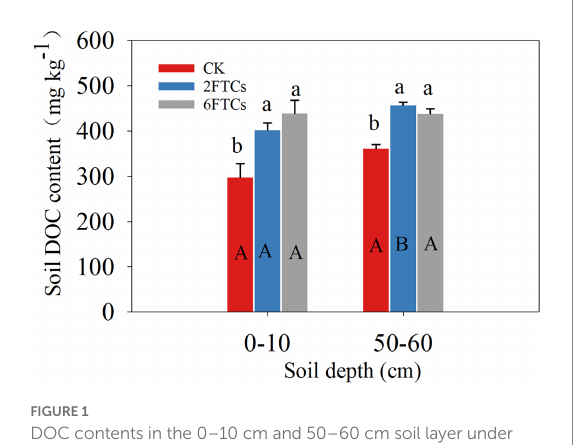
FIGURE 1 DOC contents in the 0–10 cm and 50–60 cm soil layer under different freeze–thaw cycles. CK was cultured at 5 ° C, while 2FTC, and 6FTC represent freeze–thaw treatment of 2 cycles and 6 cycles, respectively. Different lowercase letters indicate significant differences within each freeze–thaw treatment ( p < 0.05). Different capital letters showed significant differences between the two soil dephts ( p < 0.05).